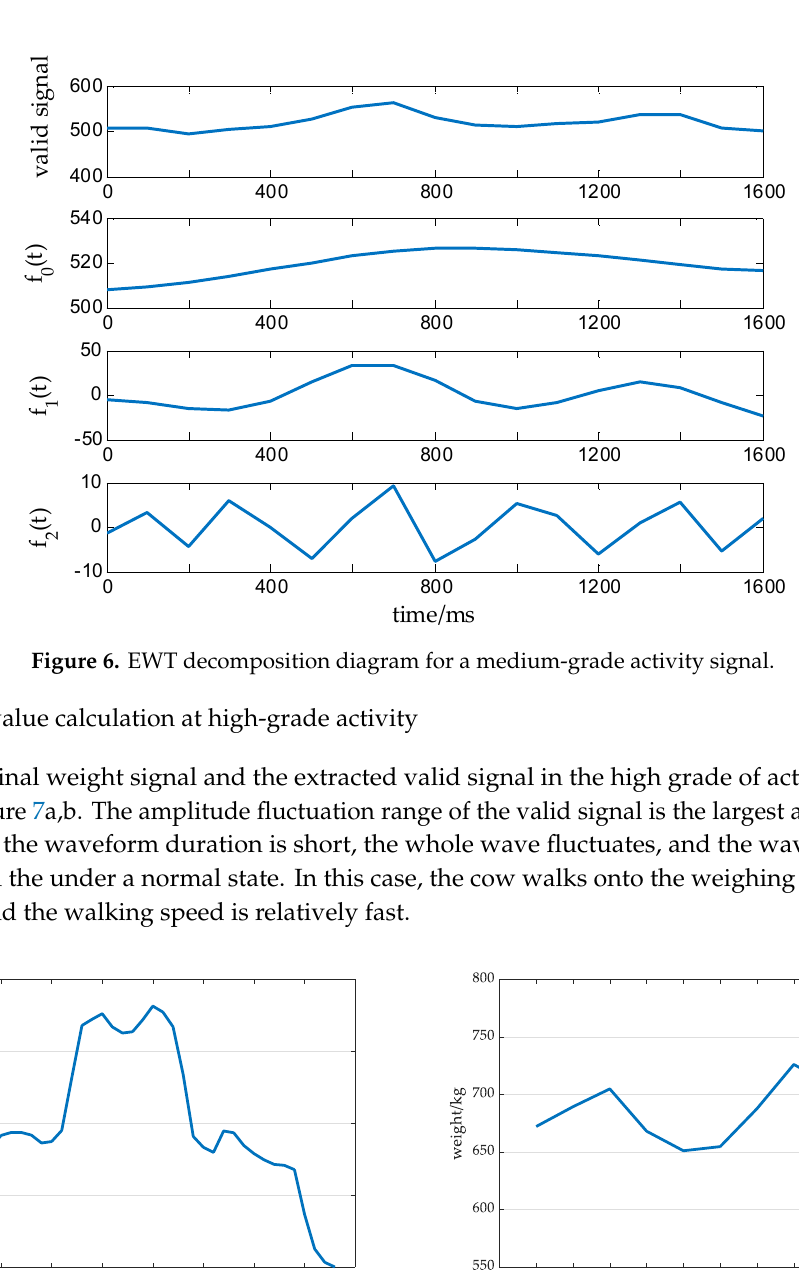
Figure 5. Original weight signal and valid signal at a medium grade of active degree: ( a ) Original weight signal at a medium grade; ( b ) Valid signal at a medium grade.